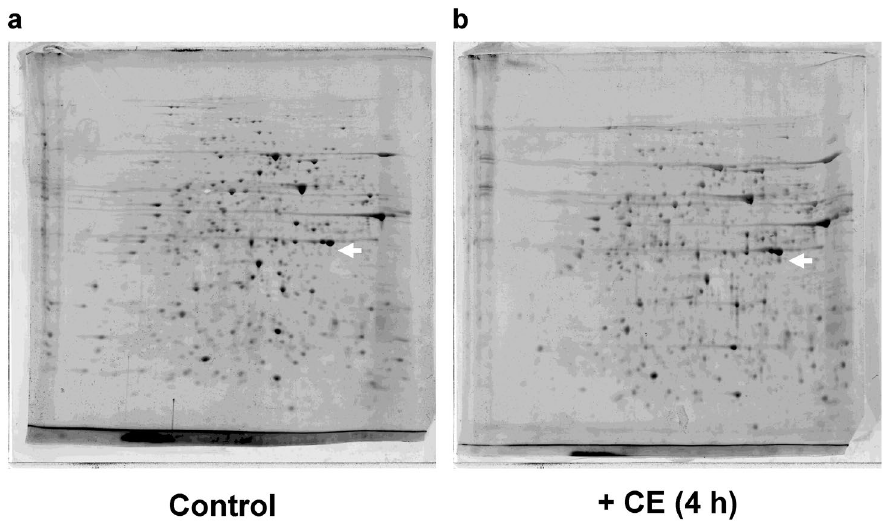
Figure 1. Two-dimensional gel electrophoresis of the total protein extracted from cinnamon extract treated 3T3-L1 adipocytes. Total proteins extracted from 3T3-L1 adipocytes were separated using two identical two- dimensional electrophoresis gels. ( a ) The full-length Flamingo Fluorescent Protein Gel staining patterns of untreated adipocytes and ( b ) adipocytes treated with 30 μg/mL of cinnamon extract (CE) for 4 h. n =